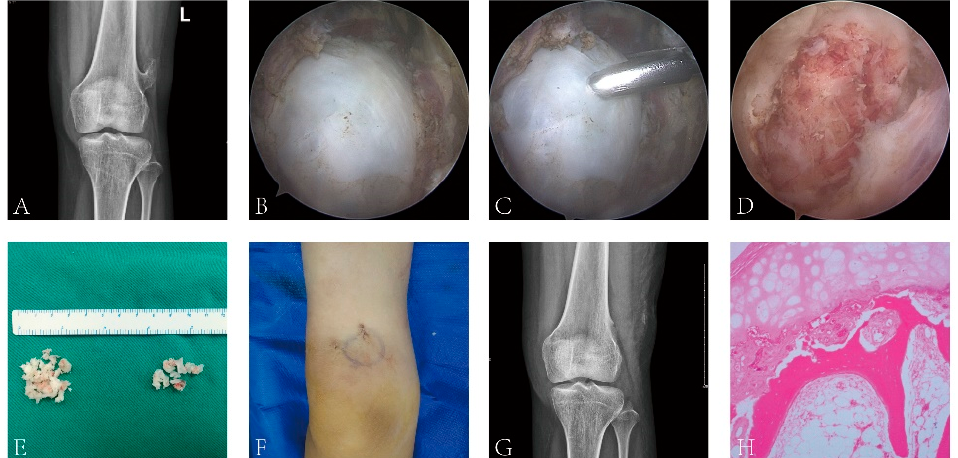
Figure 1. Image data of arthroscopic resection of extra-articular osteochondroma of the knee. ( A ) Preoperative X-ray can clearly show osteochondroma, and the tumor and surrounding tissue are